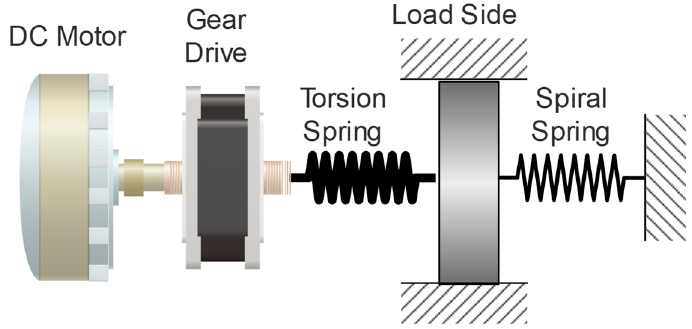
Figure 2 . ES-RSEA configuration. Figure 2. ES-RSEA configuration.